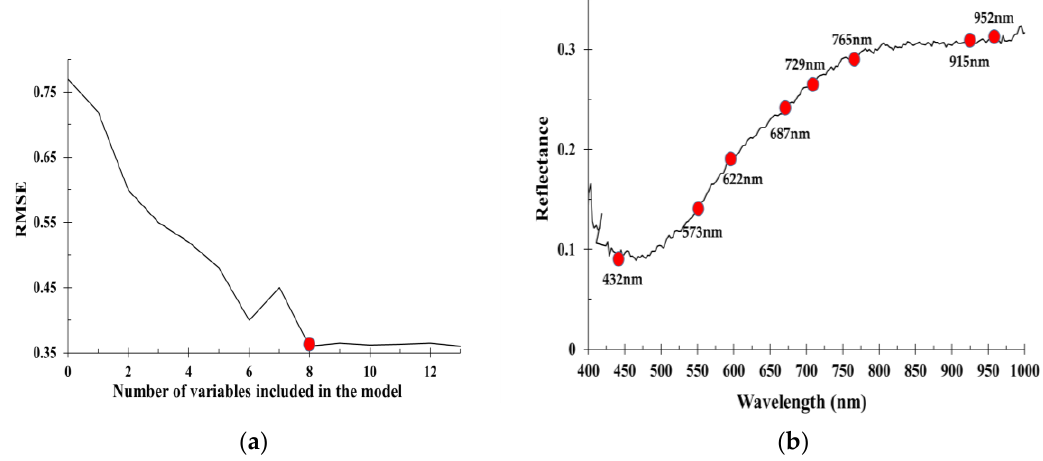
Figure 6. Selection of effective wavelengths using the successive projections algorithm: ( a ) Number of selected variables; ( b ) Effective wavelengths in visible and near-infrared regions.